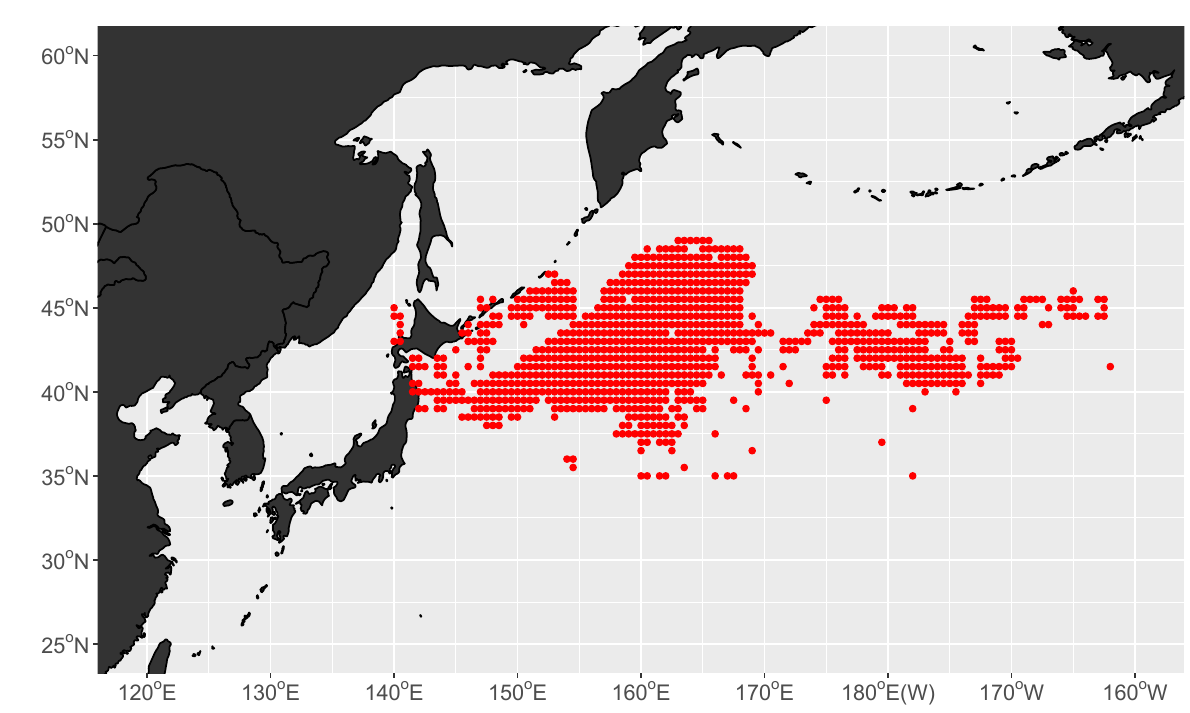
Figure 1. Distribution of fishing effort of squid-jigging vessels (represented by the red spots) in the North Pacific Ocean from July to November, 2017 to